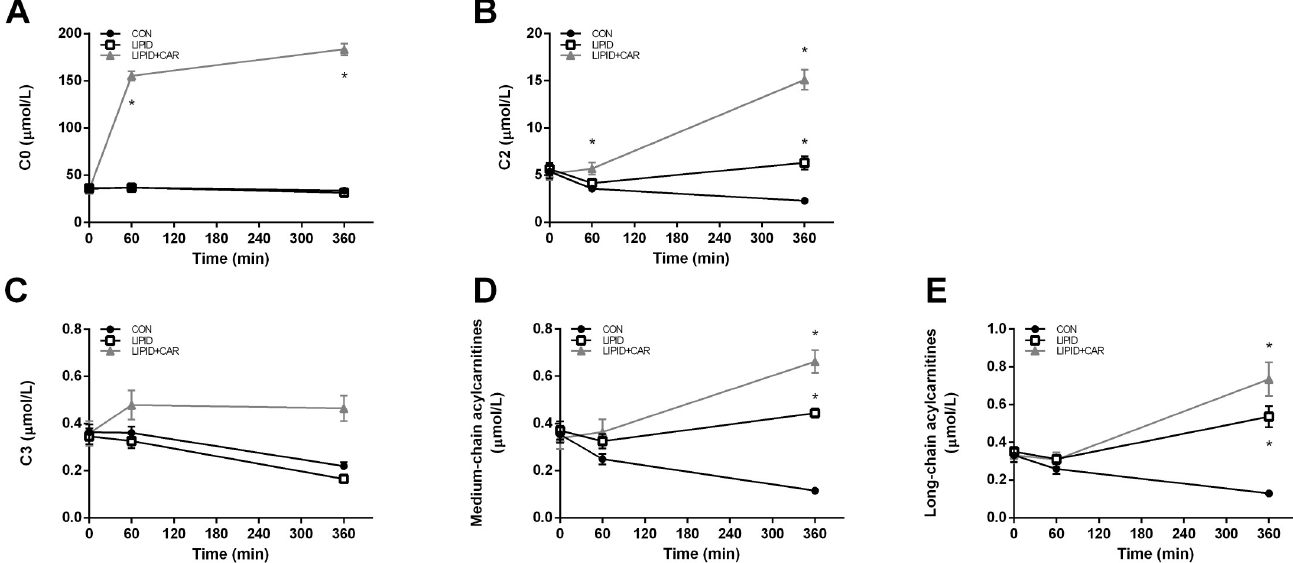
Fig 4. Plasma acylcarnitine profiles. Plasma free carnitine availability (A), acetylcarnitine (B), C3 acylcarnitine (C), medium chain acylcarnitines (D) and long- chain acylcarnitine concentrations (E) measured at baseline (t = 0), after one hour (t = 60) and at the of the 6-hour hyperinsulinemic-euglycemic clamp (t = 360) (n = 8). Black dots represent the control group, white dots the LIPID group and light grey lines the LIPID+CAR group. Data are expressed as means ± SEM. � significantly different from CON ( P < 0.05). Note: in A the lines of the control and lipid conditions are